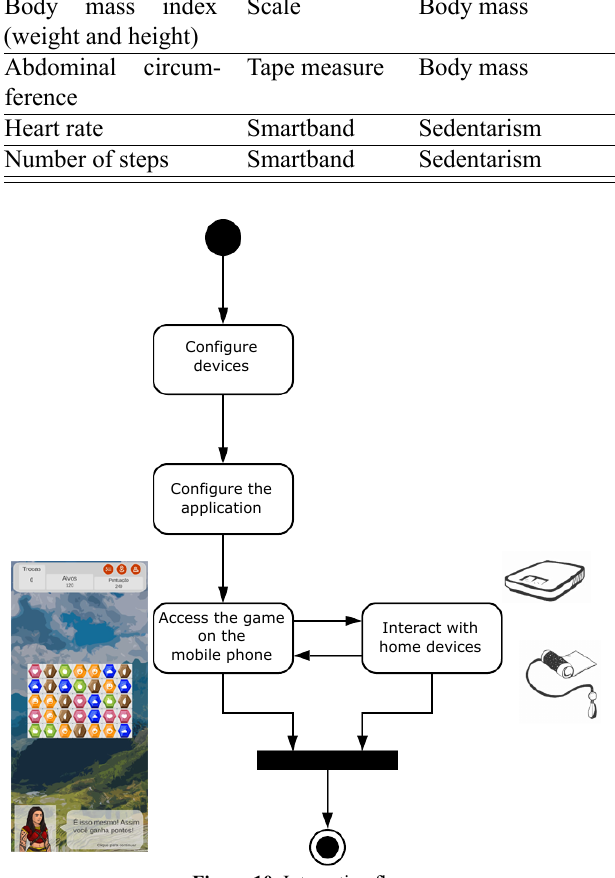
Figure 10. Interaction